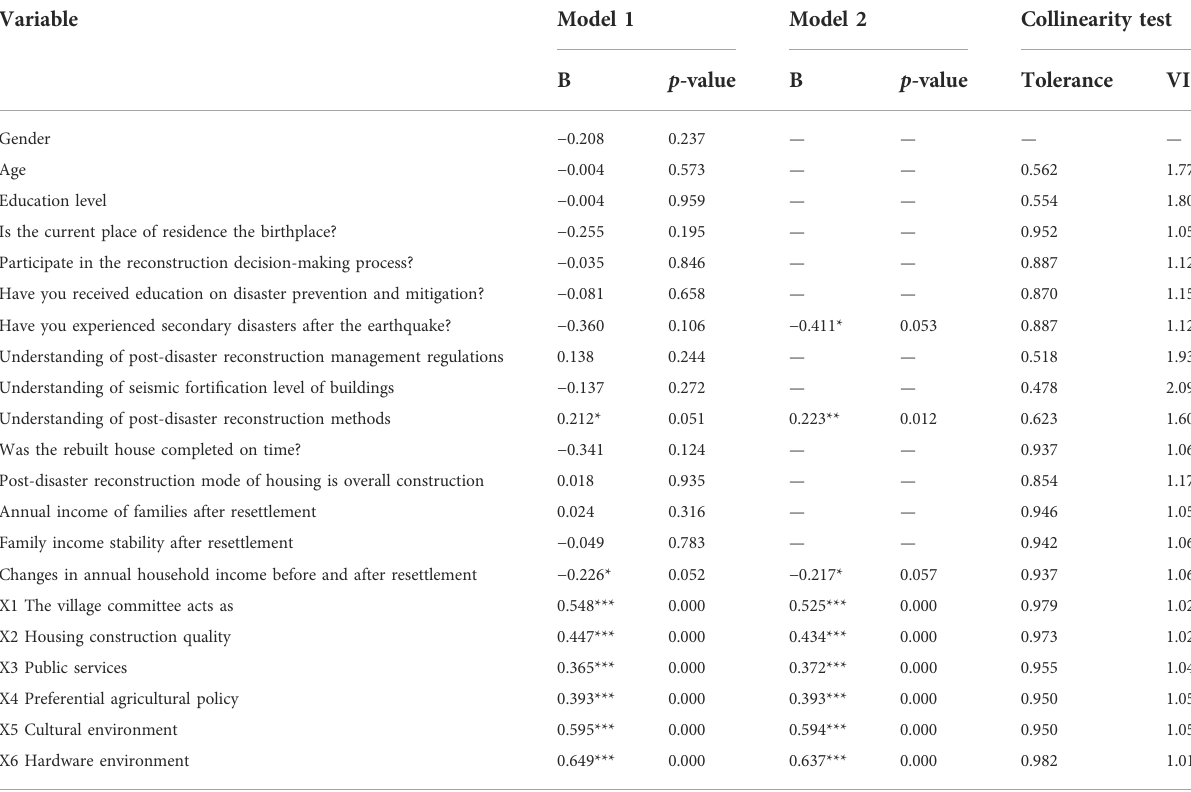
TABLE 7 Ordered logistic regression results of villagers ’